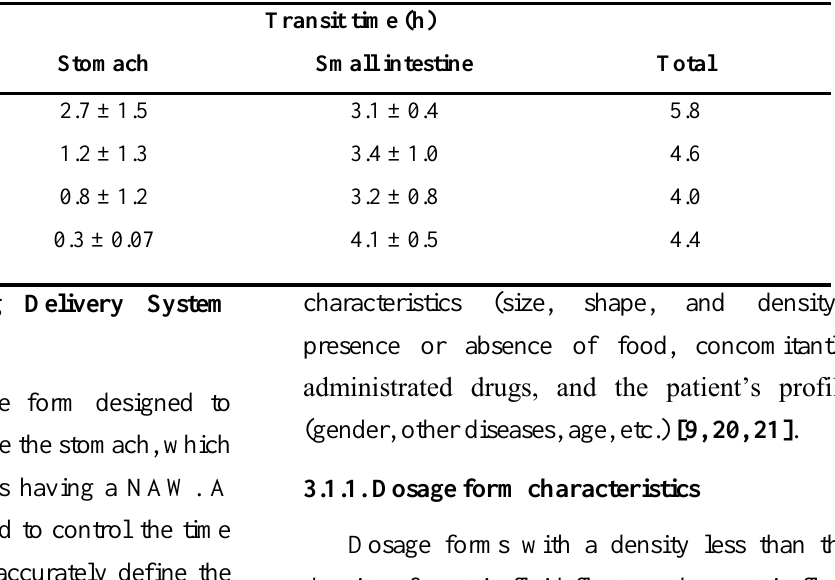
Table 1. Transit times of various dosage forms across the GIT [12,